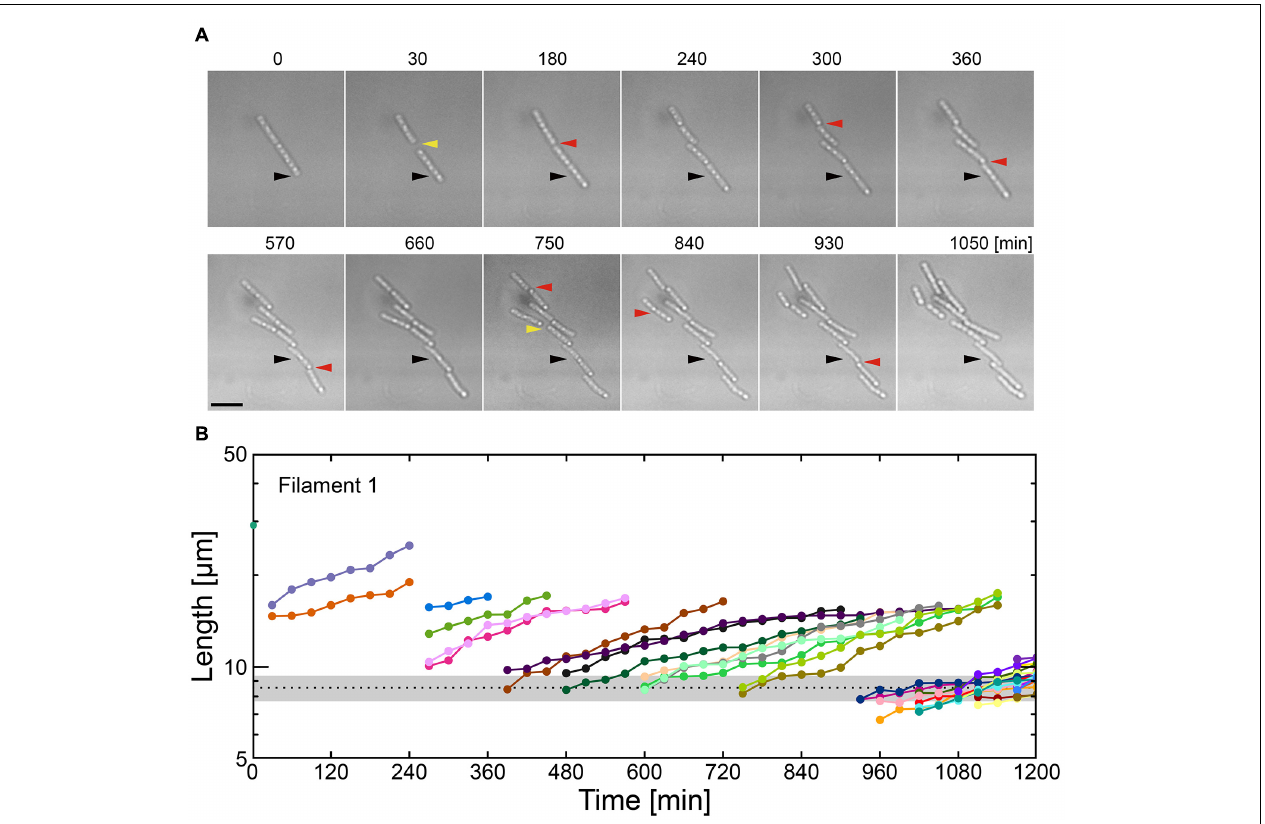
FIGURE 4 | Combinatory limitations of a carbon source and Ca 2 + causes catastrophic failure of filaments. (A) Time-lapse sequences showing frequent filament fracture in MSVP-C-Ca. Black arrowheads indicate the same spatial position in each frame, red arrowheads indicate the locations where the filament breaks, while yellow arrowheads indicate the appearance of intercellular gaps. Scale bar = 5 µ m. (B) Filament length as a function of time after fracture events corresponding to the cells in (A) . The black dotted line indicates the average length of a cell immediately after division in MSVP. (also see Supplementary Figure 11